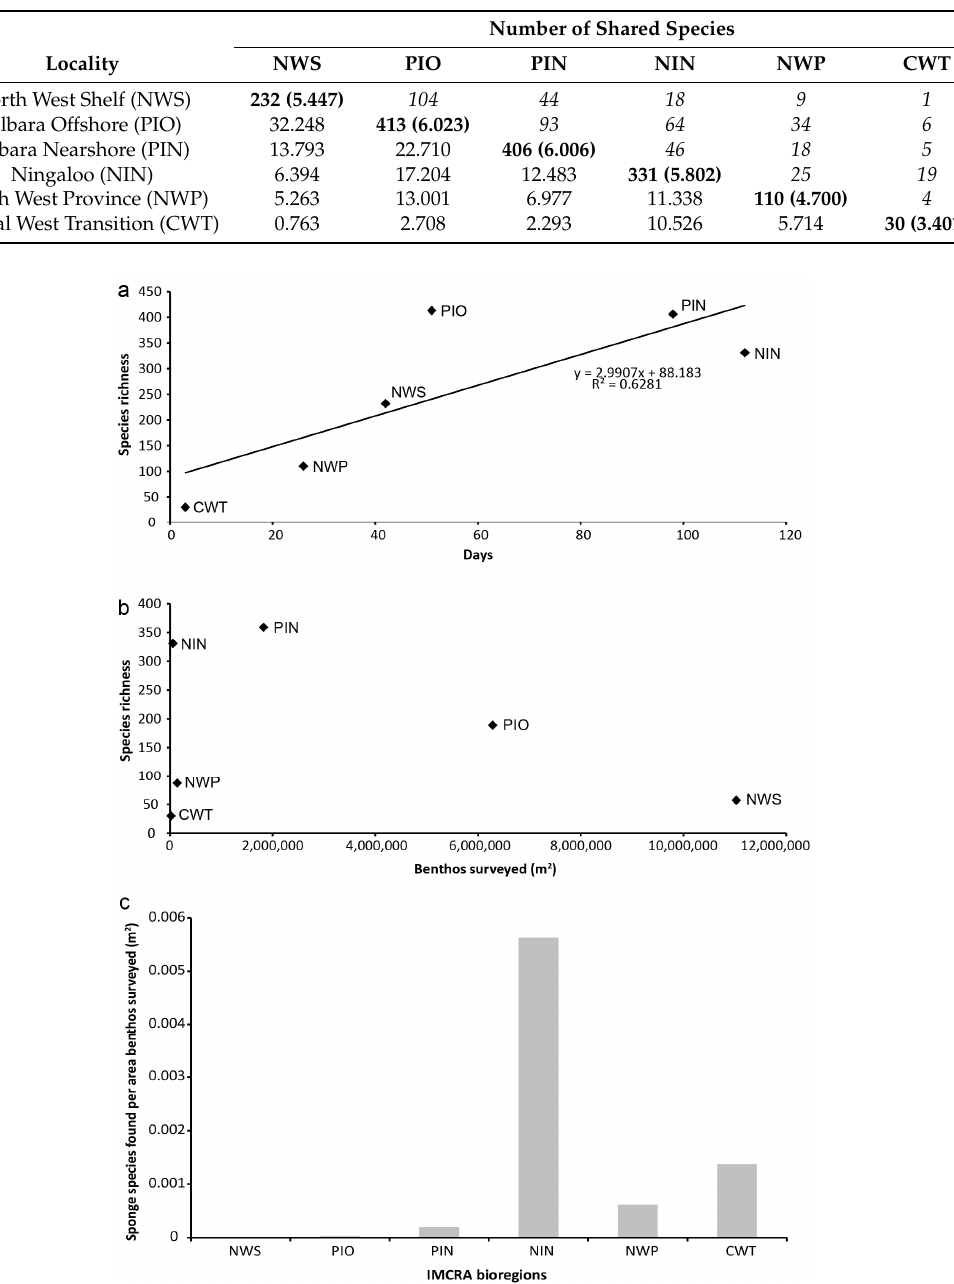
Figure 4. Sponge species richness relative to collection effort for all six bioregions in the study area. ( a ) Scatterplot and regression of sampling days and species richness; ( b ) Scatterplot of total area of benthos surveyed (m 2 ) and species richness; ( c ) Sponge species found per area of benthos surveyed